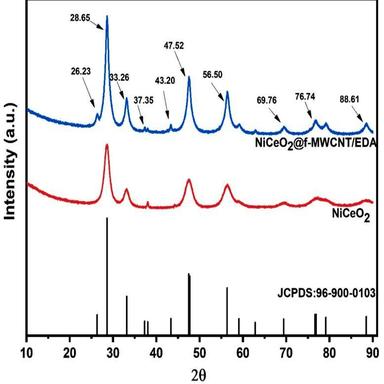
XRD analyses of NiCeO2 and NiCeO2@f-MWCNT/EDA.